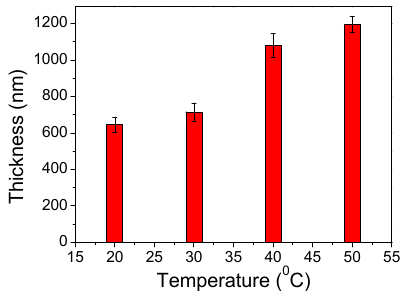
Figure 4. The thickness of (PEOX/PAA) 10 film prepared with different temperature. (PEOX, M w 50,000, 1 mg/mL; PAA, M w 450,000, 1 mg/mL; pH 2.0; assembling time, 4 min; and rinsing time, 1 min).